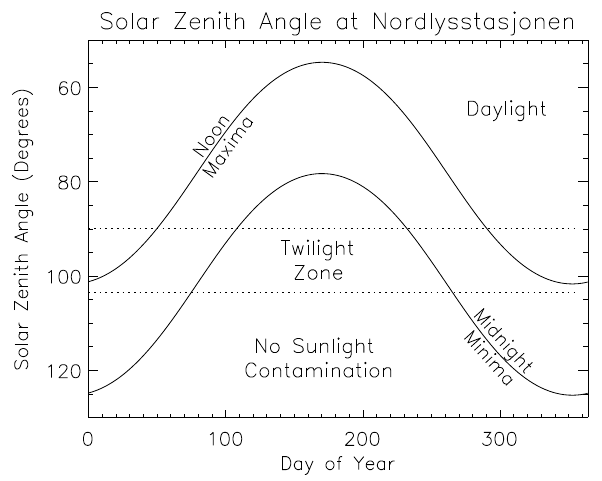
Fig. 1. The solar zenith angle (SZA) at Nordlysstasjonen over a year at noon (upper curve) and midnight (lower curve). The two horizontal dotted lines give the SZA range 90 ◦ to 103.5 ◦ over which twilight contamination is